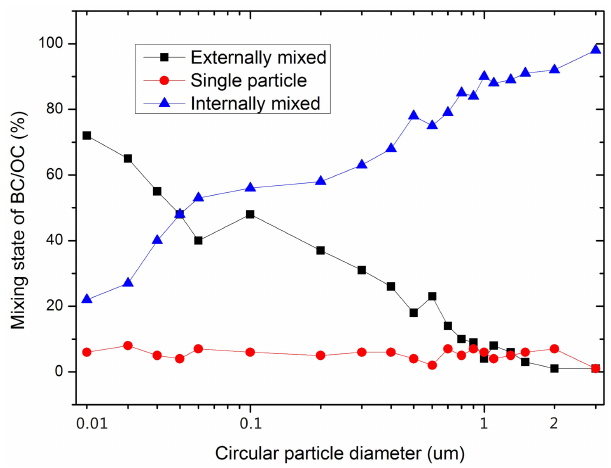
Figure 10. Average conditions of single, internally, and externally mixed BC / OM individual particles in the snowpack of northeastern Tibetan Plateau glaciers, showing most of the BC / OM with diame- ter > 1µm in internal mixing